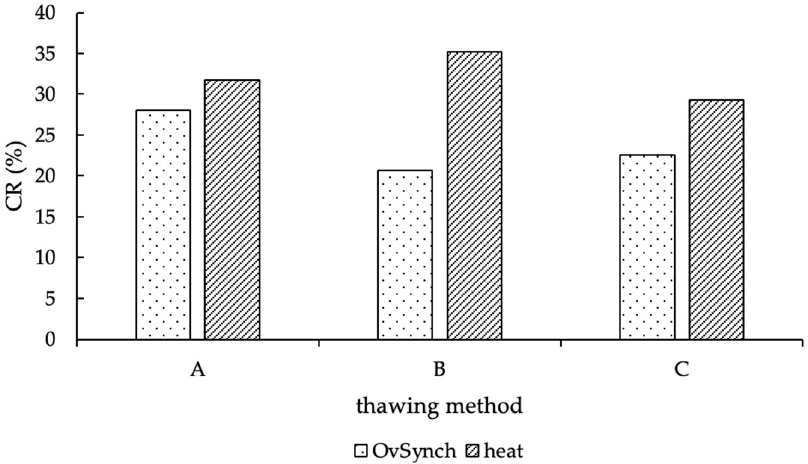
Figure 6. CR (in %) of natural heat and OvSynch-AI, according to the thawing methods (A = 11 s, 38 °C water bath; B = 35 s, 38 °C water bath; C = 30 s, “in the cow”).